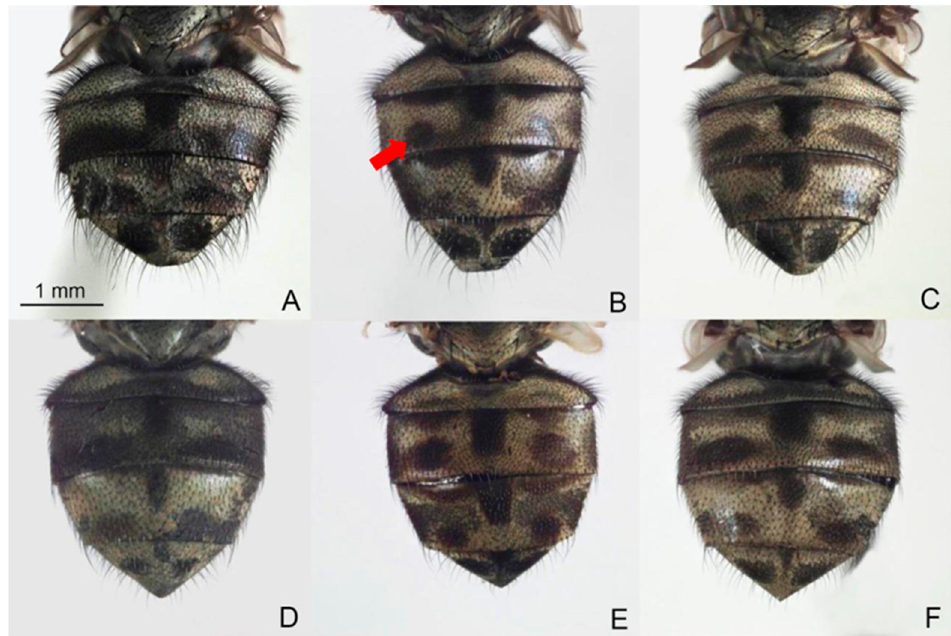
Figure 1. Male and female abdomens of Stomoxys bengalensis ( A , D ), S. calcitrans ( B , E ), and S. sitiens ( C , F ). The spot pattern (arrow) is used to distinguish among species. Photos are made by authors.